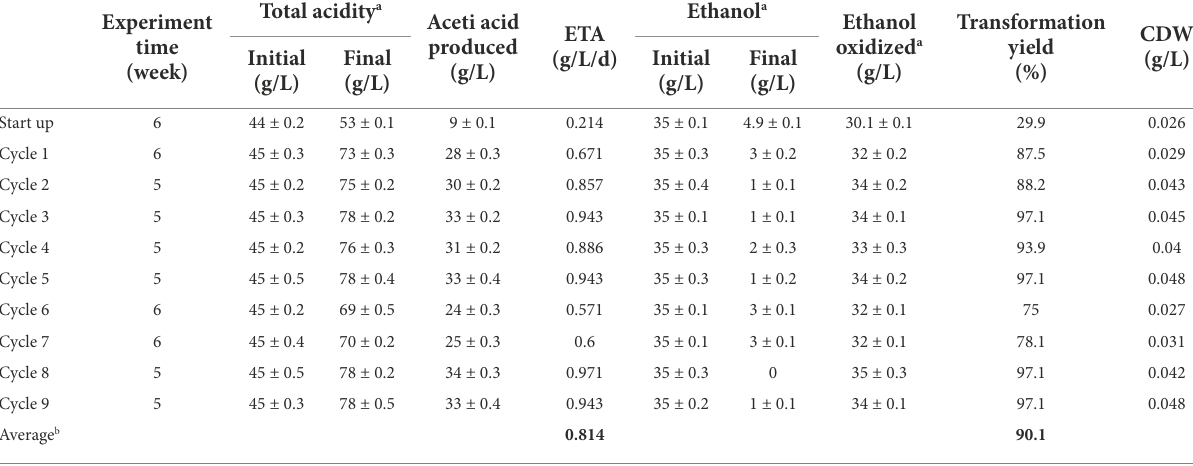
Average b 0.814 90.1 a Values represent the mean ± standard deviation of triplicate. b Average ETA and transformation yield (values in bold) were calculated among nine semi-continuous cycles, not including start-up phase. ETA, acetification rate; CDW, cell dried weight.